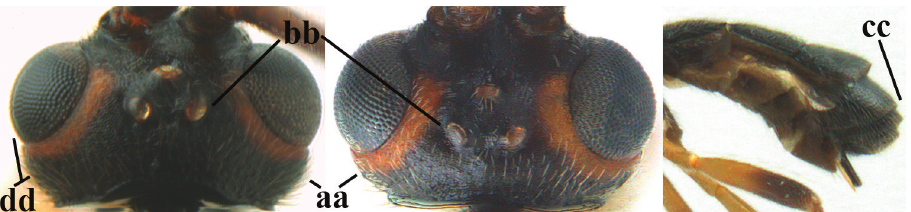
– Head behind eyes gradually (roundly) narrowed in dorsal view (aa); ocelli medium-sized (bb); apex of metasoma of ♀ black or dark brown (cc); temple medium-sized (dd) .................................................................................... 26